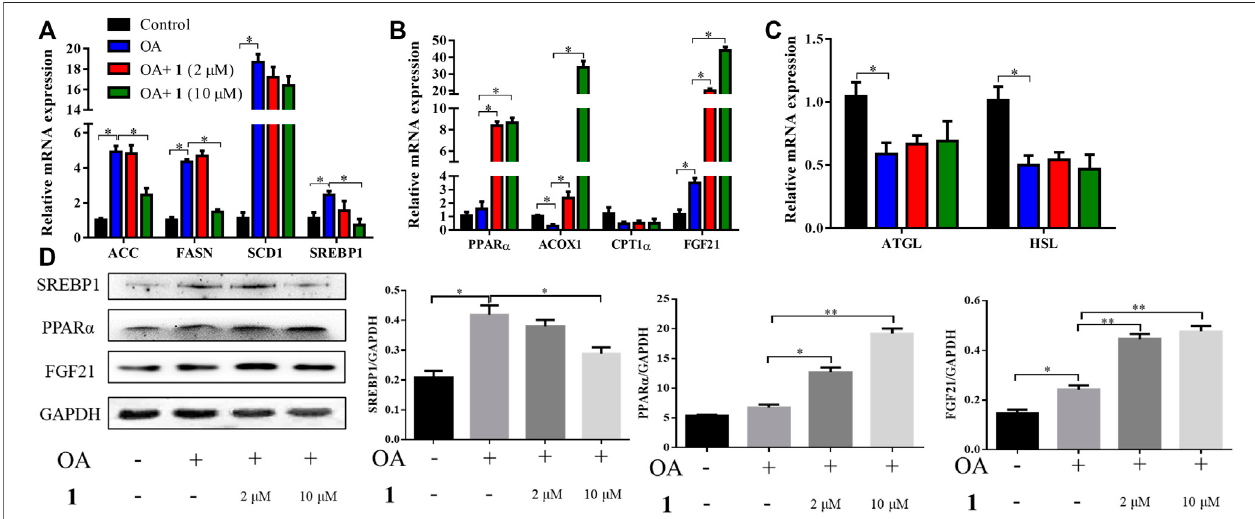
FIGURE3| (+)-DehydrovomifoliolmodulateslipidmetabolismgenesinHepG2cells.HepG2cellswerepretreated for30 minwithdifferentconcentrationsof 1 and then stimulated with10 μ Moleicacid(OA)for24 h. Then,themRNA levelsofgenesrelated tolipidmetabolism,including (A) lipogenesis (B) fatty acidoxidation, and (C) lipolysis, were detected using RT-QPCR. (D) Western blotting analysis of Srebp1, PPAR α , and FGF21 protein levels in HepG2 cells and quanti fi cation by densitometric scanning. Data shown in the bar chart are expressed as the mean ± SEM ( n (cid:2) 3). * p < 0.05, ** p < 0.01.